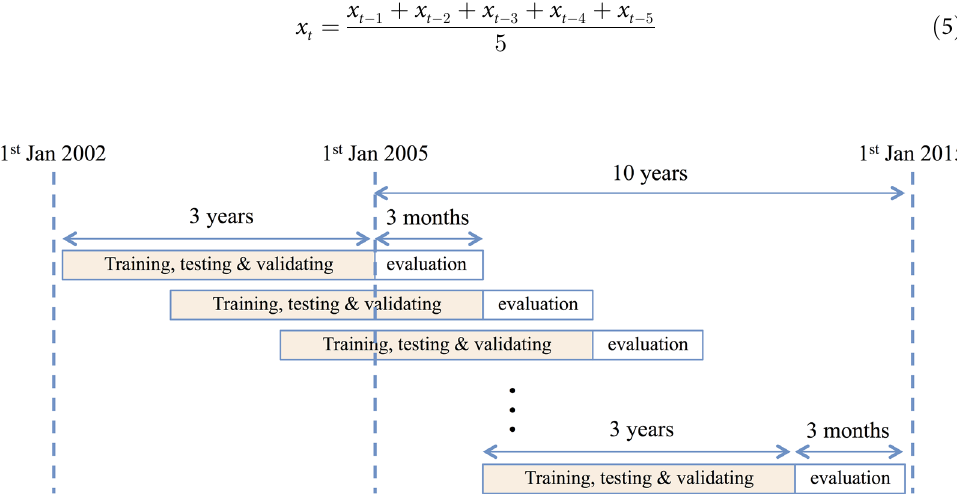
Fig 2. Continuously datasets arrangement for training and evaluation, 2005 –